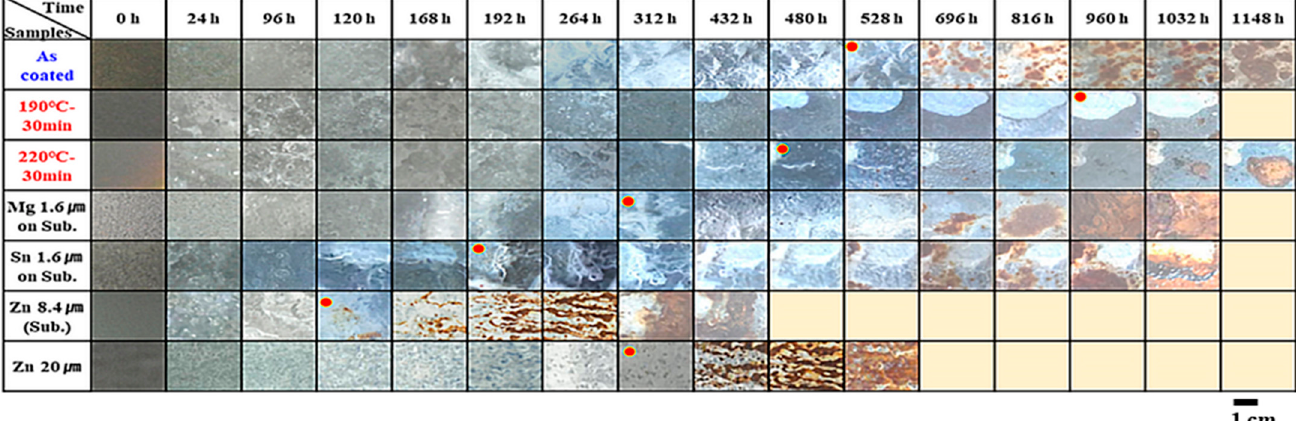
drozincite) or Zn 5 (OH) 8 Cl 2 H 2 O (Simonkolleite), which temporarily delay the degradation of